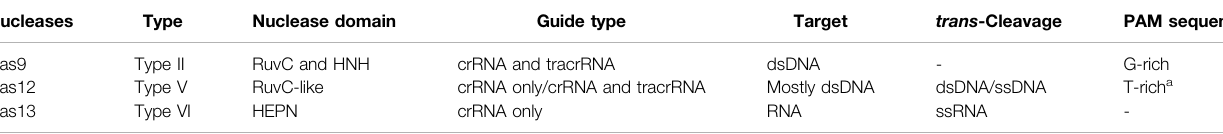
TABLE 1 | Main features of most used Class II Cas